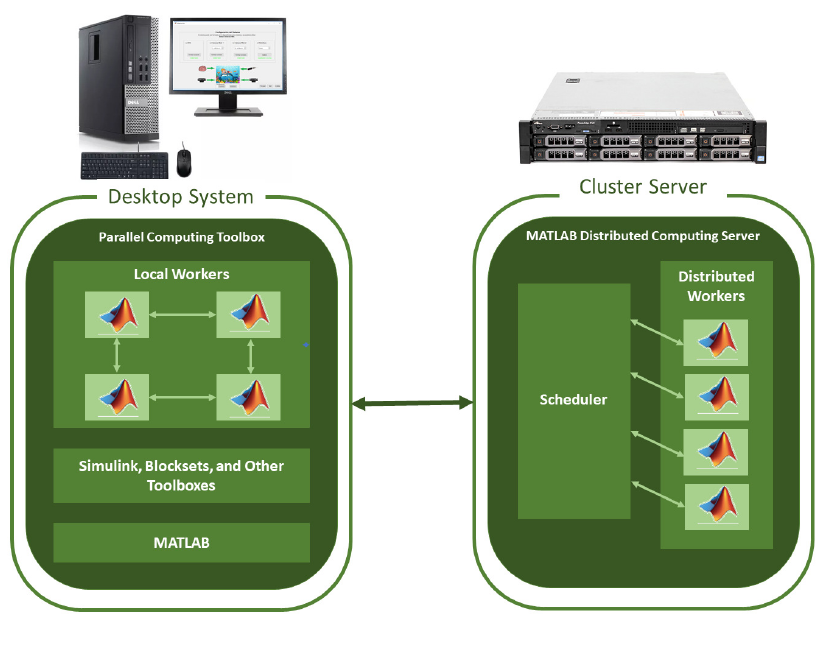
Figure 1. Matlab R2019b Parallel-Computing configuration for local and distributed